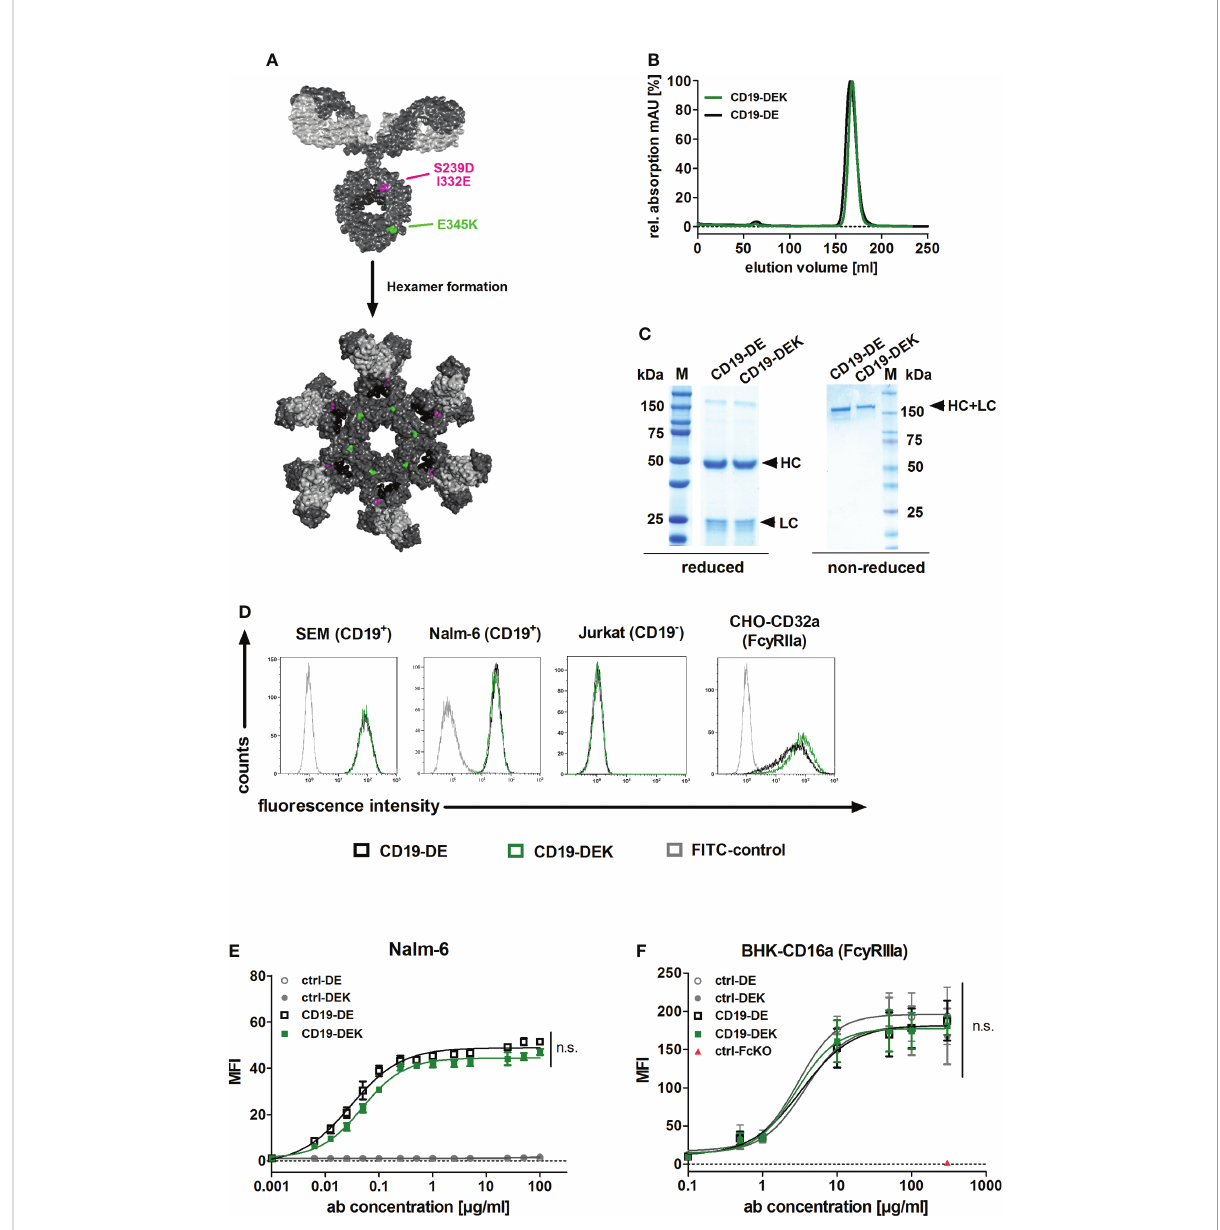
FIGURE 1 Generation and binding characteristics of CD19-DEK. (A) Schematic illustration of a CD19-antibody with a dual engineered Fc part for improved Fc g R binding and effector cell recruitment (DE-variant: S239D/I332E, pink) and ef fi cient recruitment of the complement system (C1q) via E345K amino acid substitution (green) to favor antibody hexamerization on the target cell surface resulting in improved CDC. IgG model structure based on pdb fi le provided by Dr. Mike Clark (63) and Hexamer model structure based on crystal structure of IgG1-b12 (1HZH) provided by Dr. Rob de Jong was modi fi ed using Discovery Studio Visualizer (Biovia). (B) CD19-DEK and CD19-DE were analyzed by size exclusion chromatography. (C) SDS-PAGE under reducing and non-reducing conditions and Coomassie blue staining validated the purity and molecular mass of the dual-engineered CD19 antibody compared to CD19-DE. (D) Binding speci fi city of CD19-DEK and CD19-DE was tested via fl ow cytometry on CD19-positive cell lines SEM and Nalm-6. The CD19-negative T-ALL cell line Jurkat was used as control. The binding capacity of the optimized Fc part to Fc g RIIa was investigated by fl ow cytometry on stably transfected cells. Data show representative results of three independent experiments. (E) Concentration dependent binding of CD19-DEK and CD19-DE compared to isotype control antibodies (ctrl-DE and crtl-DEK) was tested with the CD19-positive BCP-ALL cell line Nalm-6 via fl ow cytometry. (F) Concentration dependent binding of the optimized Fc part of CD19-DEK and CD19-DE to Fc g RIIIa was analyzed by fl ow cytometry on stably transfected BHK cell line (BHK-CD16a). A control antibody with a silent Fc domain lacking Fc g R binding (ctrl-FcKO) was used as a negative control. Mean values ± SEM of three independent experiments, * P <0.05%, ns, not signi fi cant. Two-way ANOVA with Bonferroni